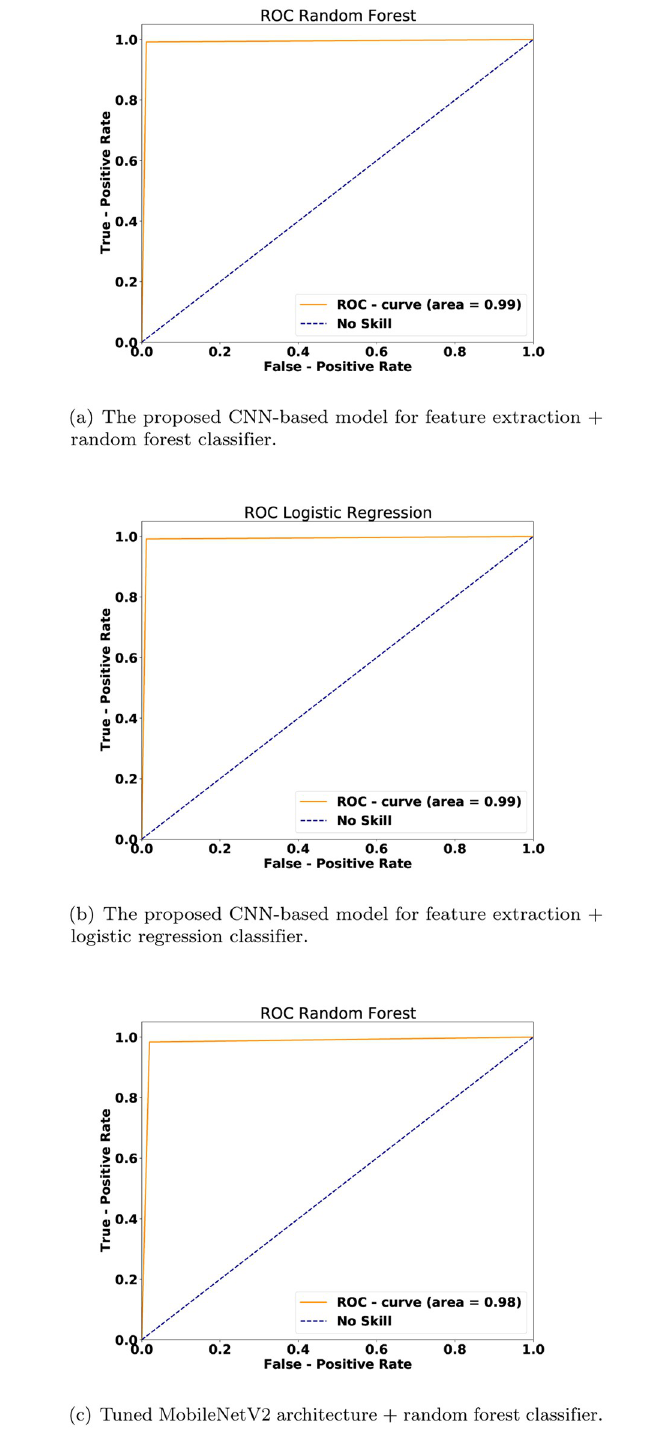
Fig 5. ROC AUC curve (a) the proposed CNN model+random forest classifier (b) the proposed CNN model +logistic regression classifier (c) tuned MobileNetV2 + random forest classifier.